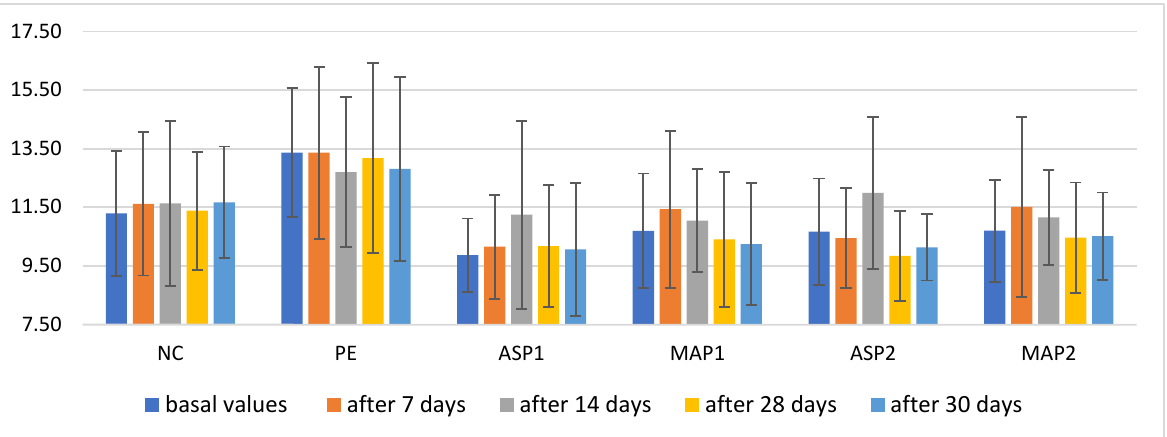
Figure 3. In vivo determined mean values with a standard deviation of trans-epidermal water loss (TEWL) for non-treated control (NC), placebo emulgel (PE) and investigated emulgels (ASP1, MAP1, ASP2 and MAP2) after 7, 14, and 28 days of application, and 2 days after the cessation of application.